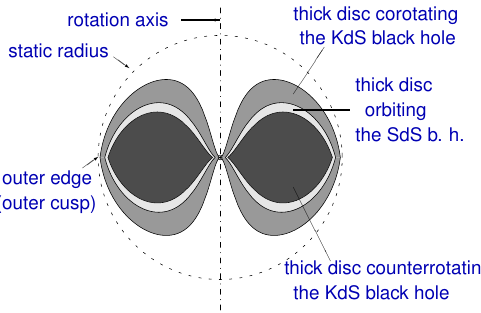
Figure 8. Maximally extended corotating and counterrotating tori around a Kerr–de Sitter (KdS) black hole, compared to an analogical torus around Schwarzschild–de Sitter (SdS) black hole. The corotating one is more